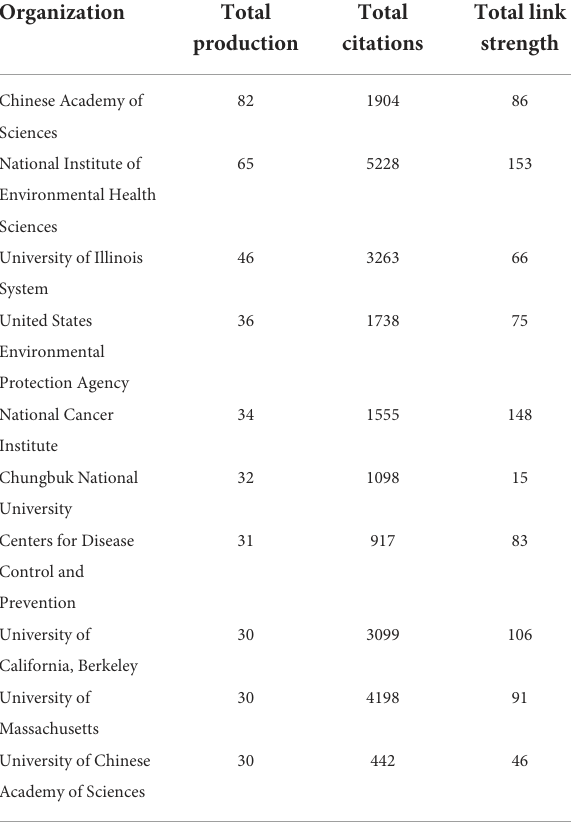
TABLE 3 Most productive organizations contributing to this research field. Organization